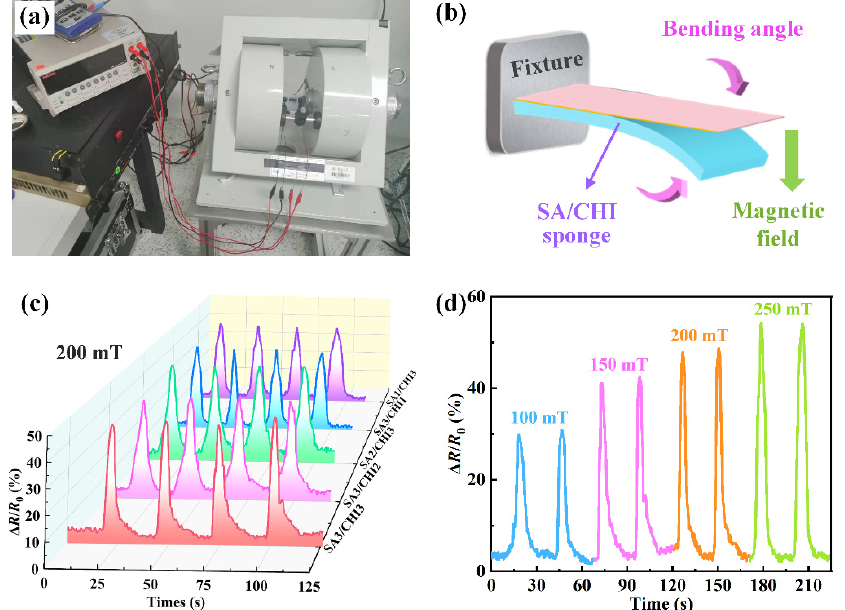
Figure 8. ( a ) Photographs of the experimental setup in the magnetic responsive performance test. ( b ) Schematic illustration of magnetic responsive behavior for SA/CHI sponge. ( c ) Cyclic tests of relative resistance variation for different SA/CHI sponge sensors under the magnetic field of 200 mT. ( d ) Relative resistance variation from 100 to 250 mT for SA3/CHI2 sponge sensor.